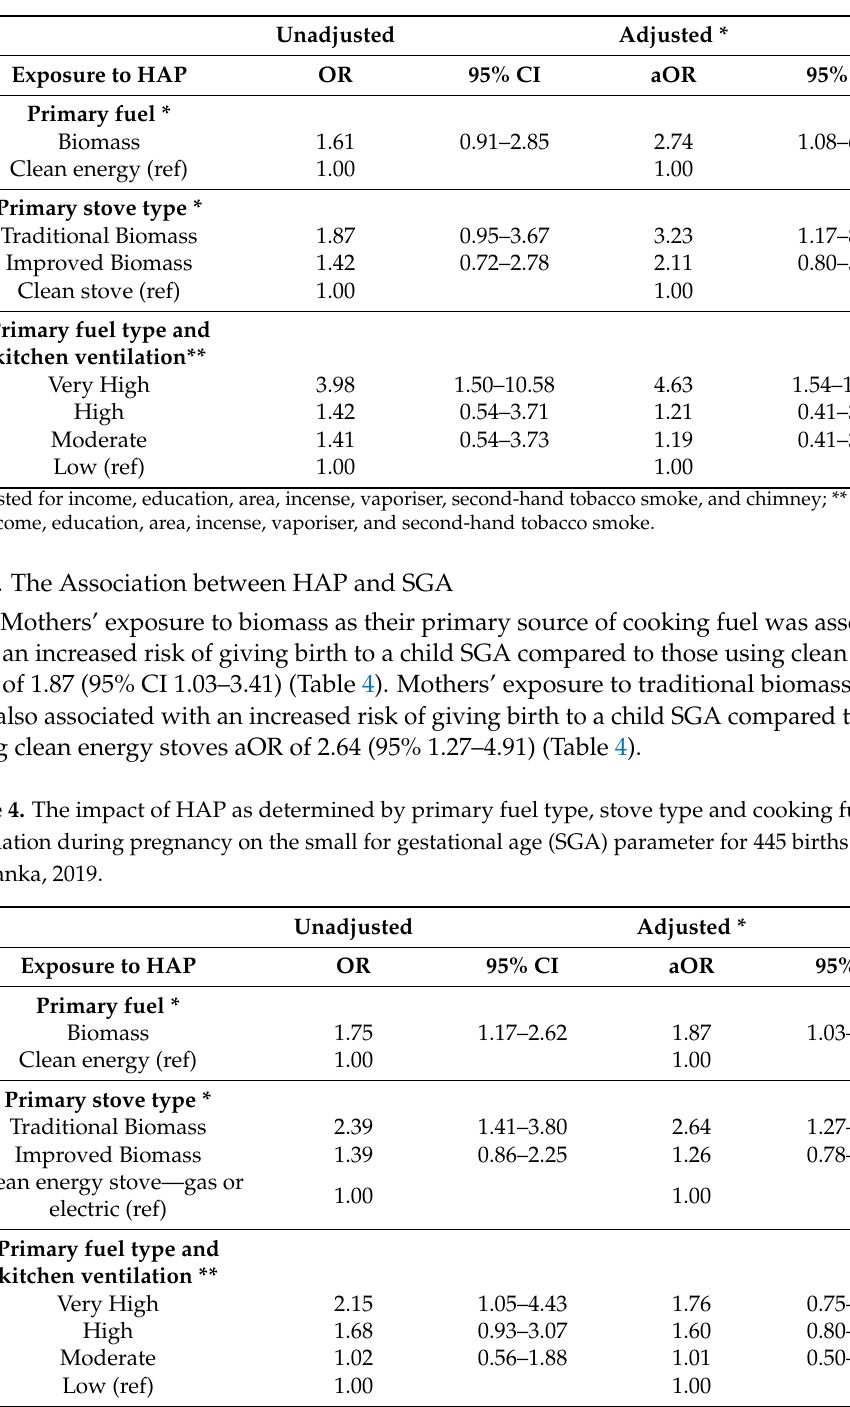
Table 3. The impact of household air pollution (HAP) as determined by primary fuel type, stove type and cooking fuel, and ventilation during pregnancy on low birth weight (LBW) for 445 births in rural Sri Lanka, 2019.